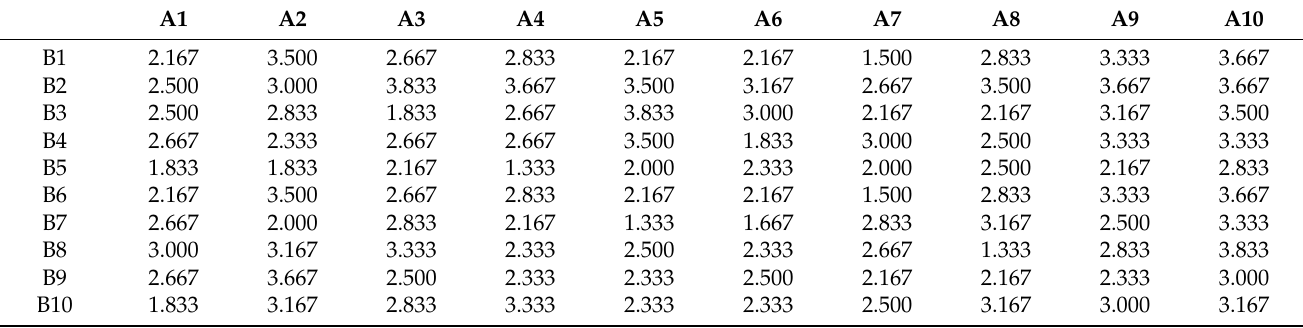
Table 6. The initial